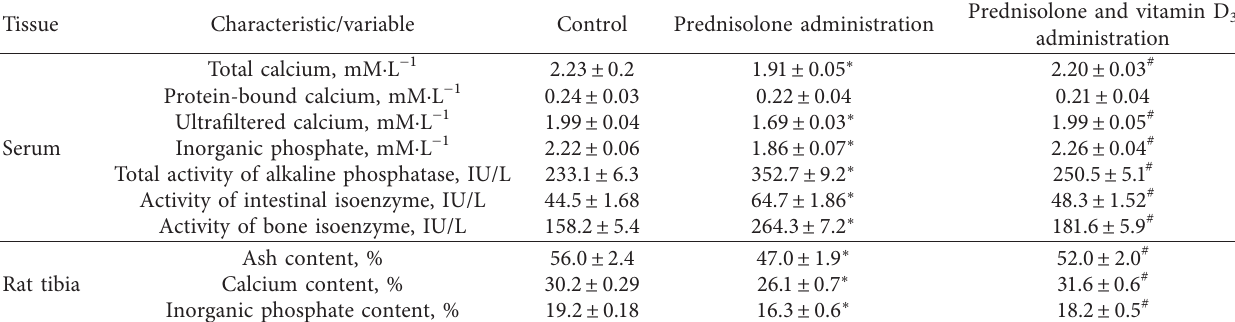
Table 1: Bone turnover characteristics of rats with glucocorticoids-induced osteoporosis and after vitamin D ( n �